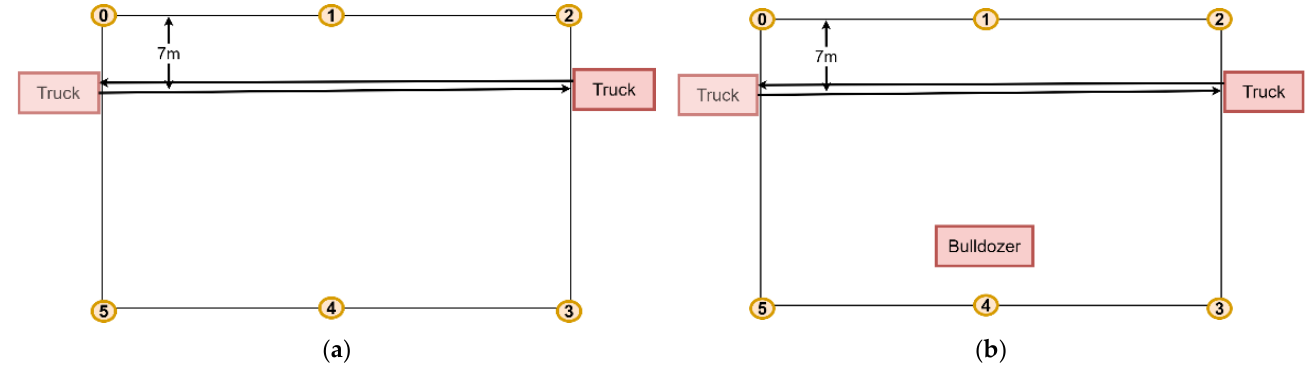
Figure 7. Vehicle tracking for scenarios ( a ) without blocking objects and ( b ) with a blocking object.